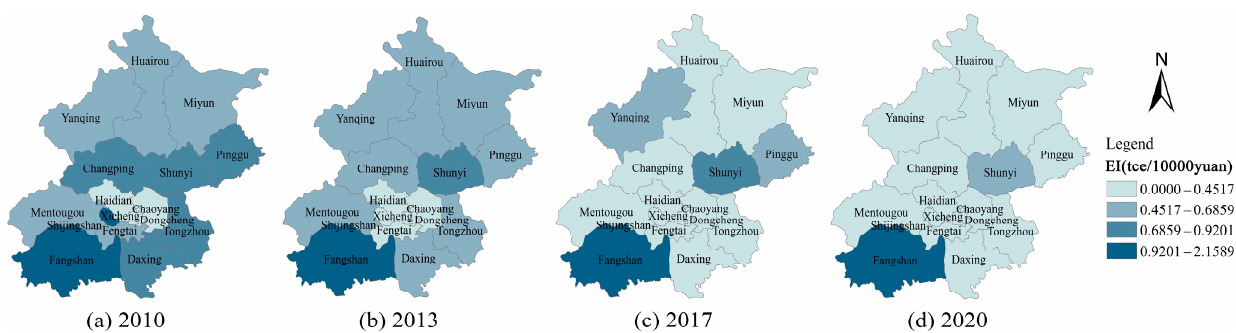
Figure 4. Development trend of carbon emissions in Beijing’s municipalities from 2010 to 2020.